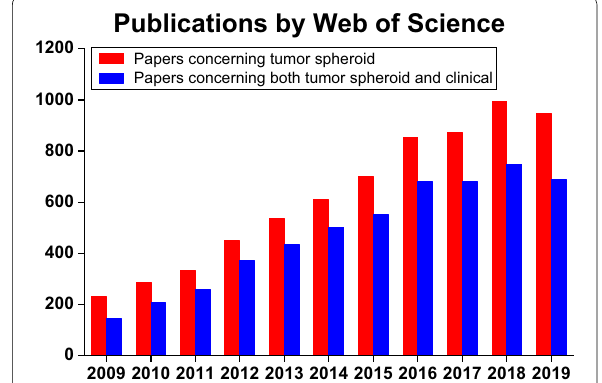
Fig. 2 The number of papers published over the past decade (2009– 2019) with regard to multicellular tumor spheroid and clinical. The figure shows the result of searching either keywords “tumor spheroid” or both “tumor spheroid” and “clinical” in Web of Science